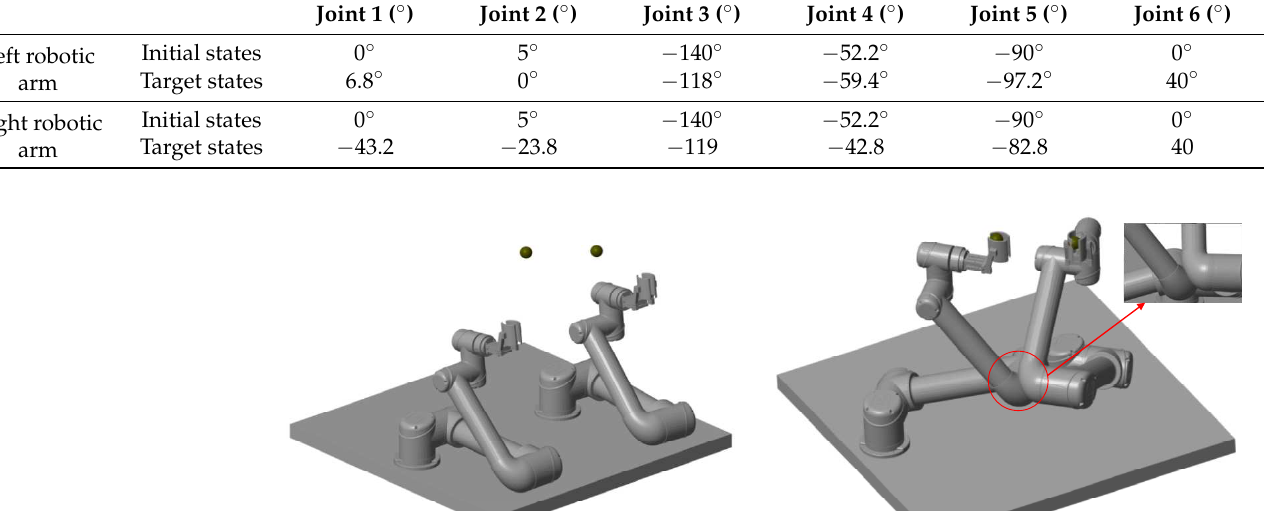
Figure 17. Two-arm picking plan in the collision area. ( a ) No collision detection. ( b ) Collision loca- tion.